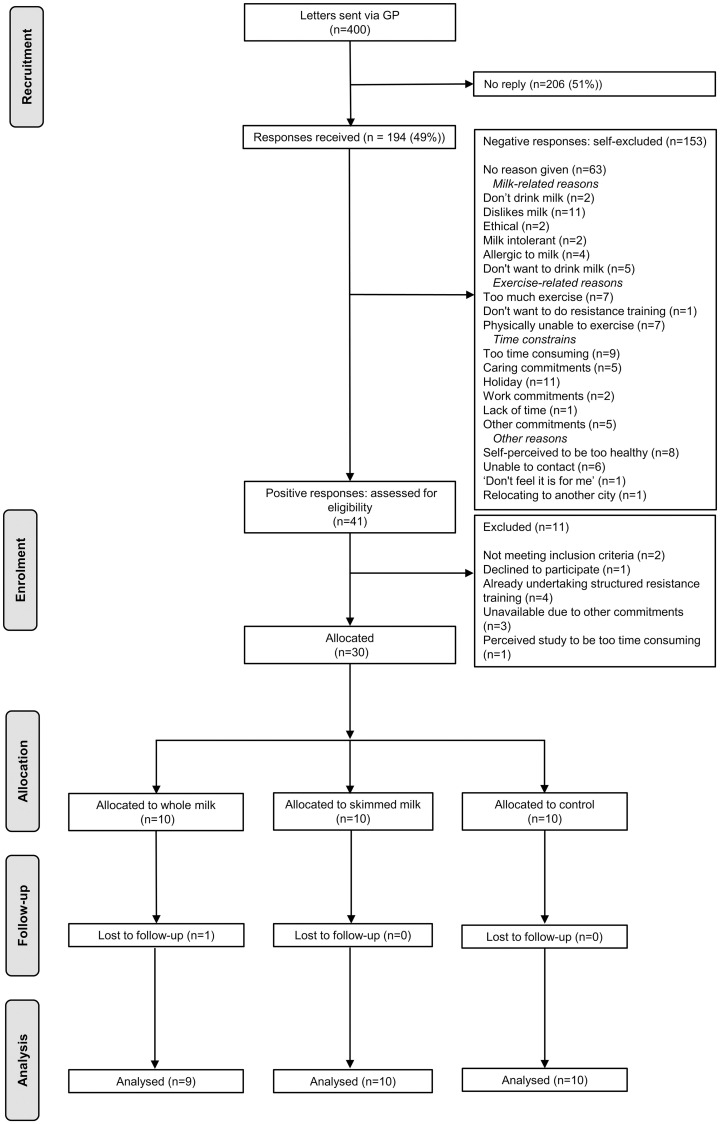
Participant flow diagram.Four hundred letters and participants’ information packs were sent through general practitioner (GP) surgeries within the National Institute for Health Research (NIHR) North East and North Cumbria Clinical Research Network (CRN). Of 194 (49%) replies, 153 participants were negative responders (i.e. self-excluded for a range of reasons), and 41 positive responders were assessed for eligibility against inclusion / exclusion criteria. Thirty participants (18 men and 12 women) were randomised into three study groups, and 29 completed the study.